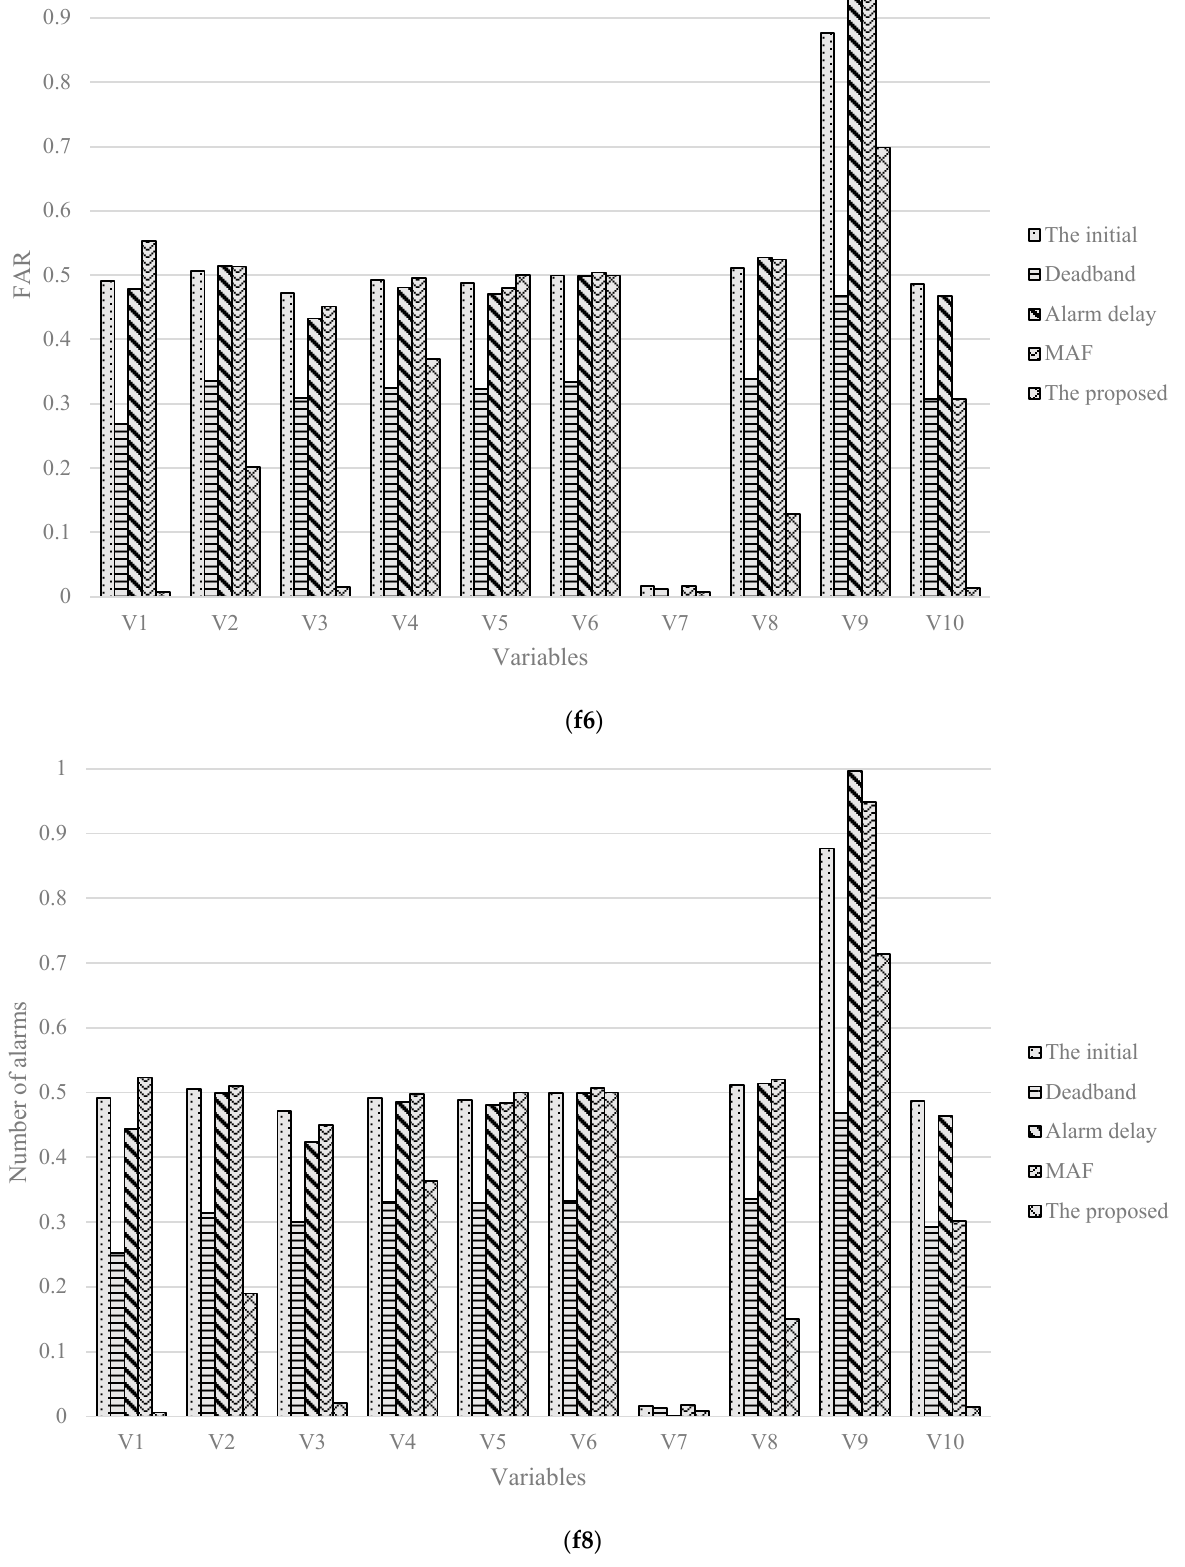
Figure 7. Histograms of FARs in five cases with two failures ( f6 , f8 ).